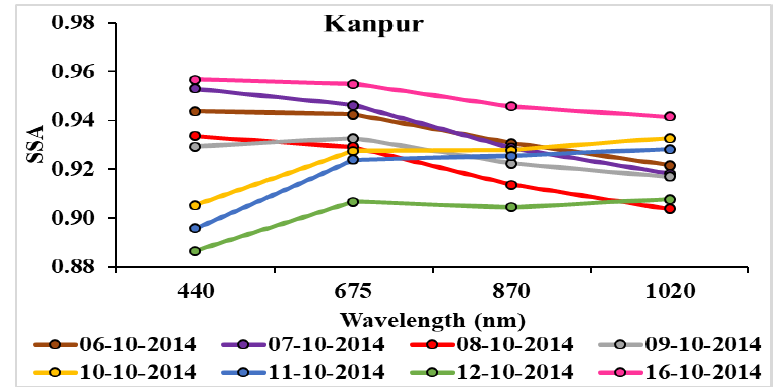
Figure 15. Frequency dependency of single scattering albedo (SSA) at four wavelengths 440, 675, 870, and 1020 at Kanpur AERONET station during 06 – 16 October 2014. No data is available on 13, 14, and 15 October.